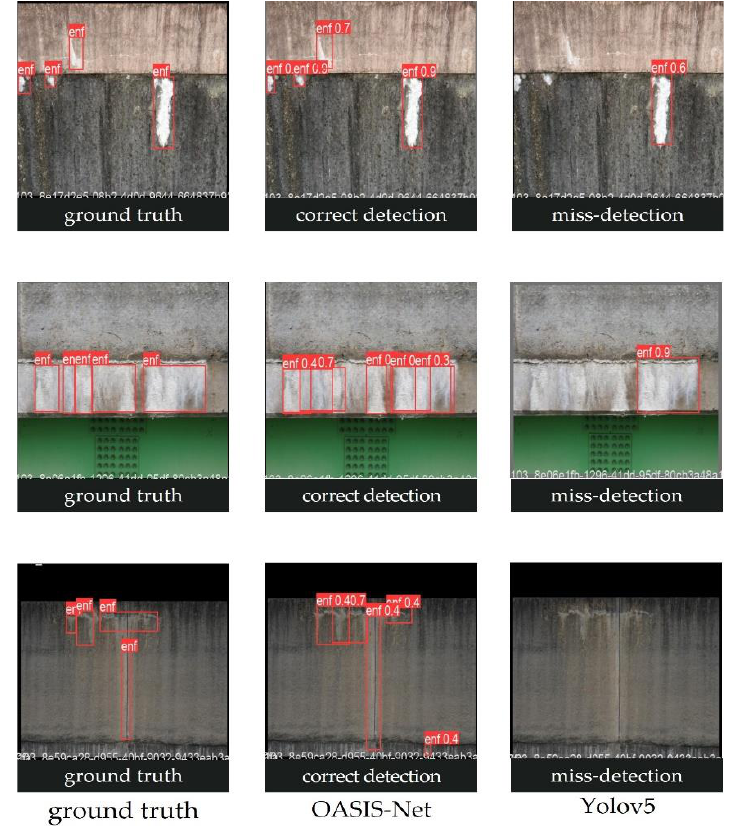
Figure 16. Visual comparison of efflorescence detection results. Table 2. Comparison of the mean average precision (mAP) for efflorescence detection.